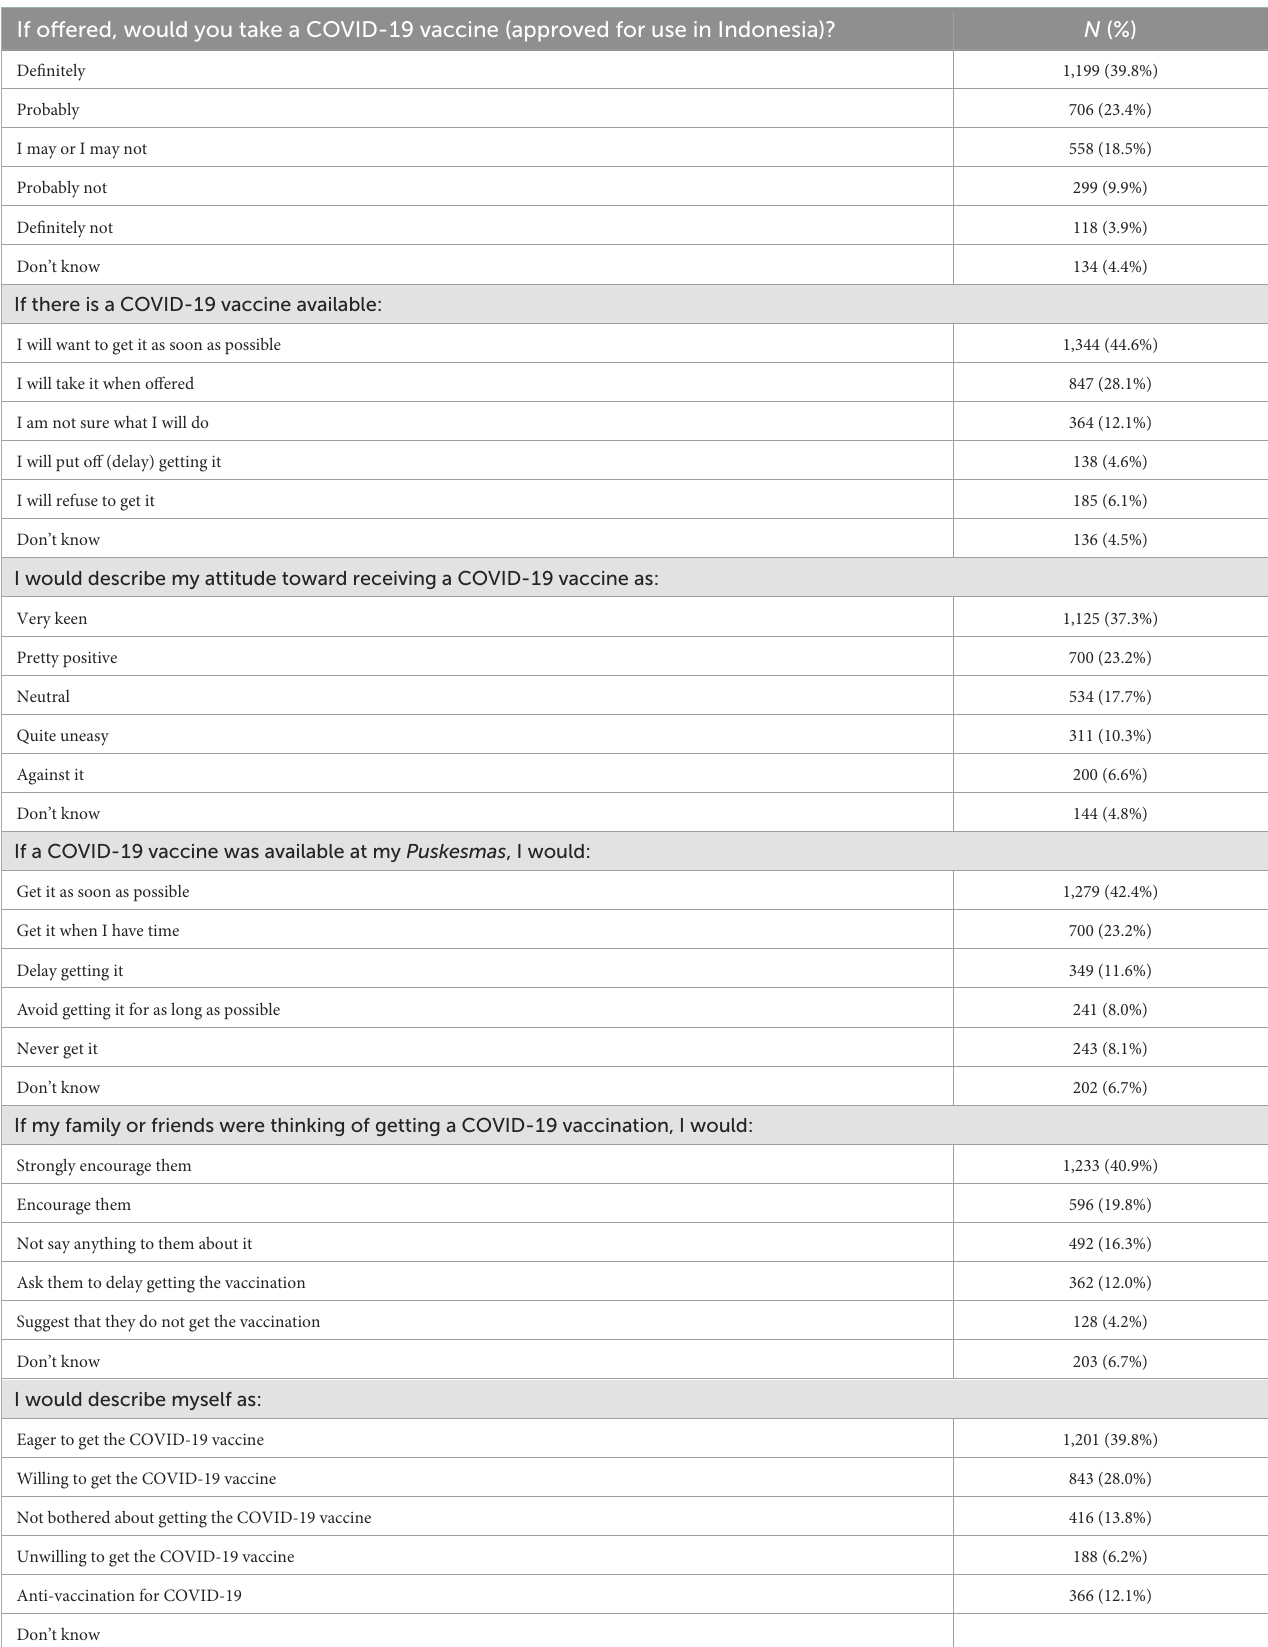
TABLE 2 Distribution of responses on each of the Oxford COVID-19 vaccine hesitancy